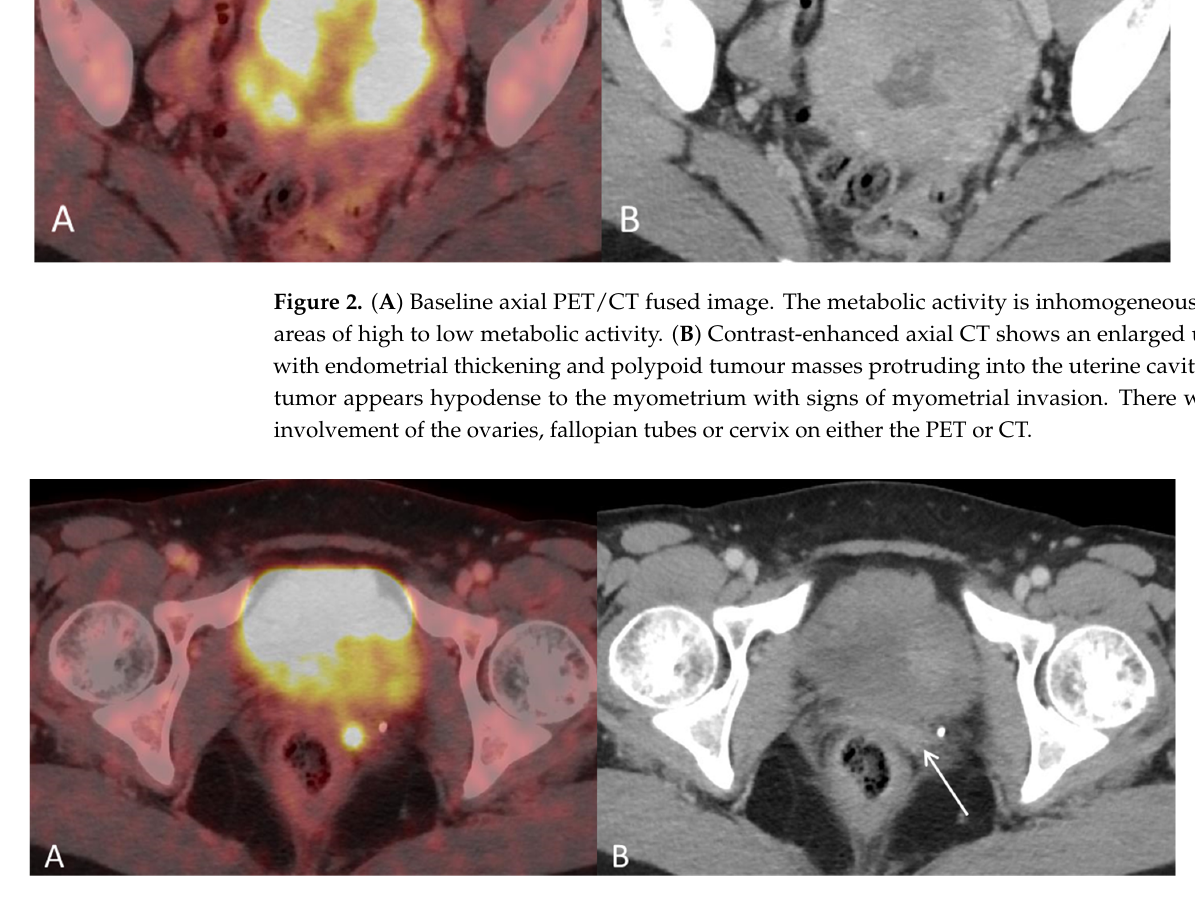
Figure 3. ( A ) Baseline axial PET/CT fused and ( B ) axial CT shows a small metabolic active hyperdense tumour located in the left vaginal corner, verified by biopsy as representing a metastasis from endometrial hepatoid adenocarcinoma ( B , arrow).